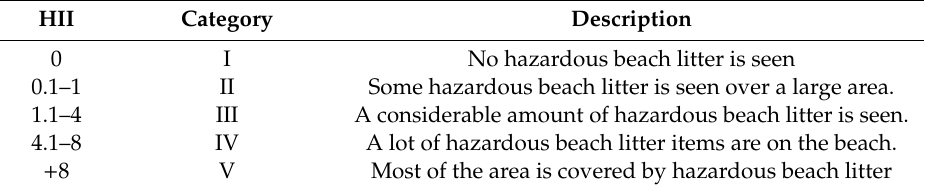
Table 2. Hazardous Items Index (HII) classification.